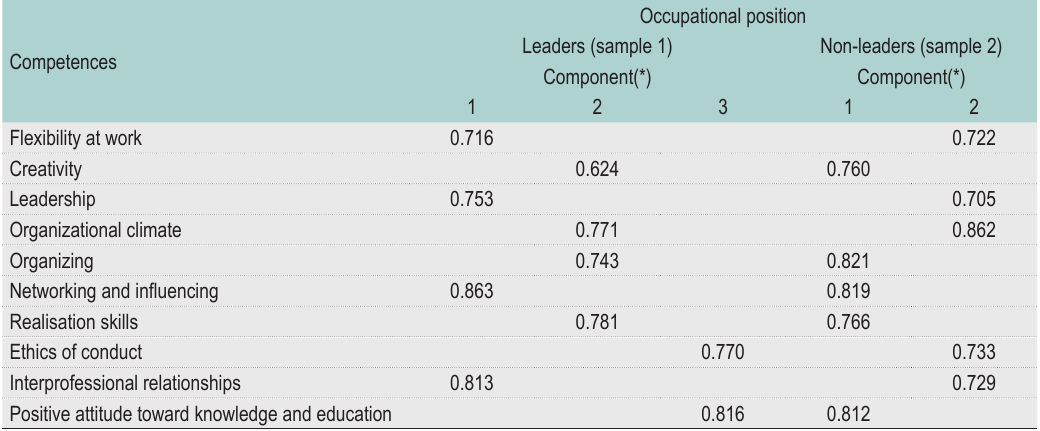
TABLE 4. Rotated component matrix for competencies